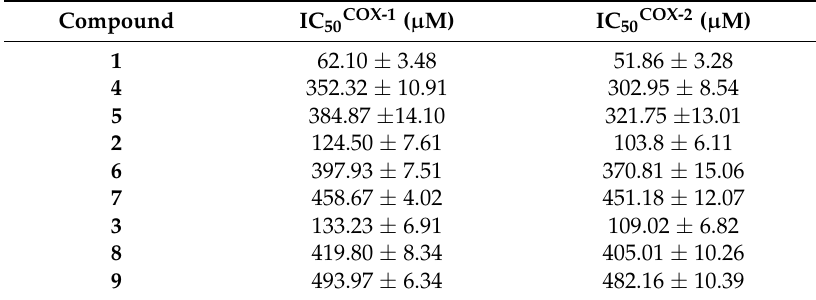
Table 2. Inhibition activity of tested compounds ( 1 – 9 ) against cyclooxygenase-1 (COX-1) and cyclooxygenase-2